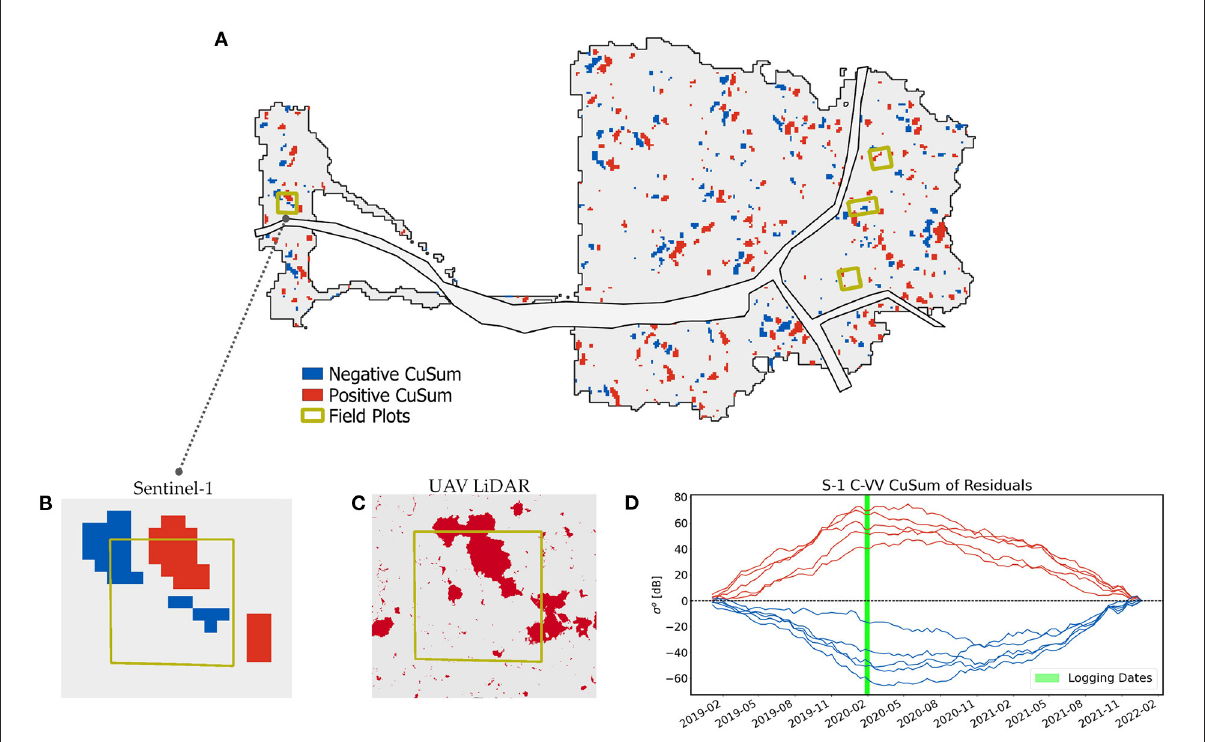
FIGURE5 (A) Image of the study area in Gabon, showing in blue the location of pixels with negative CuSum curves and in red the location of pixels with positive CuSum curves, after applying a threshold of R sum _ max = 33 for the positive values and R sum _ max = -33 for the negative values; (B) Zoom on one of the field plots (Gabon C1), indicating how positive and negative values of R sum _ max are arranged symmetrically to each others; (C) The same plot, but with canopy height loss ( ≥ 10 m) from the UAV LiDAR appearing in red; (D) CuSum curves of five pixels with negative R sum _ max (blue lines) and five pixels with positive R sum _ max (red lines) selected from the same field plot in panel (B) . The time series of the two types of pixels feature diametrically opposite trends, expressing in the time dimension the spatial symmetry that can be seen in (A,B) .